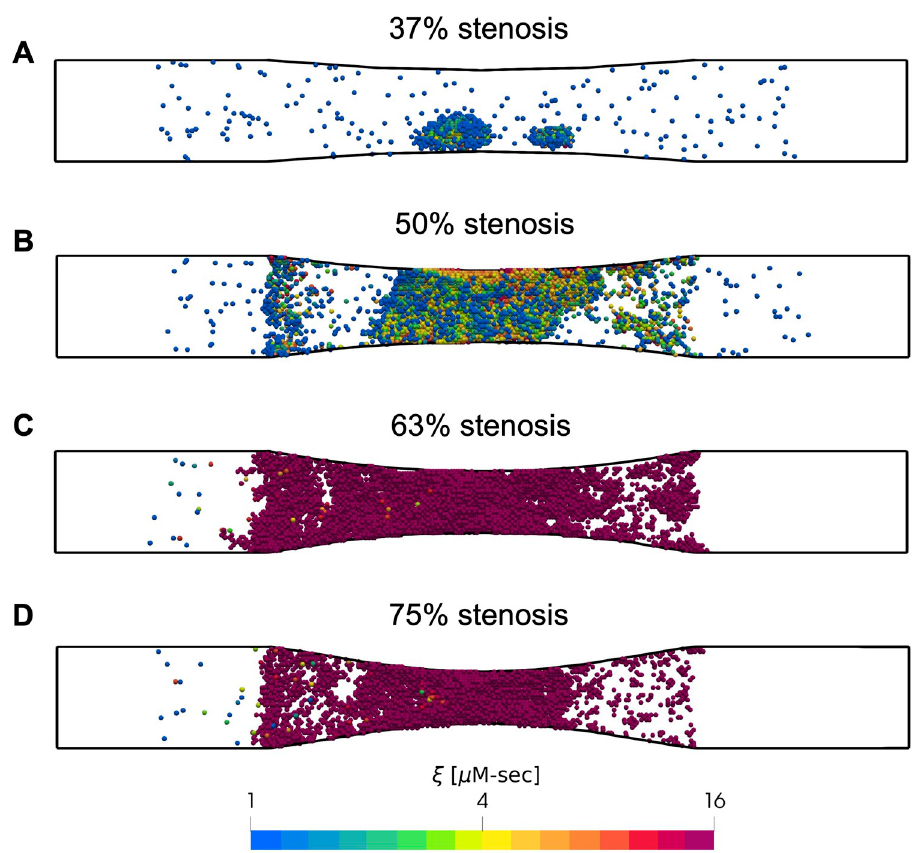
Fig 10. Effect of stenosis severity on platelet aggregation. Snapshots of platelets (blue indicates inactivated and red, highly activated) observed after 500 seconds are shown for stenoses with reductions in flow area of (A) 37%, (B) 50%, (C) 63%, and (D) 75%. Simulations were carried out under constant pressure drop that corresponded to an initial inlet wall shear rate of 1000s -1 .